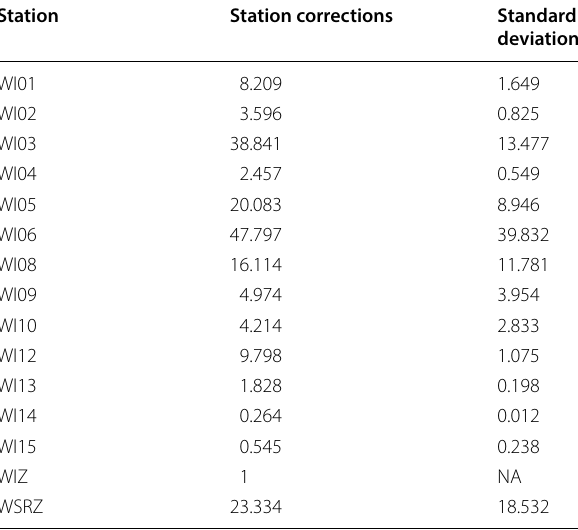
Table 1 Station corrections estimated from active sources for 15 broadband seismometers that were installed during the active source